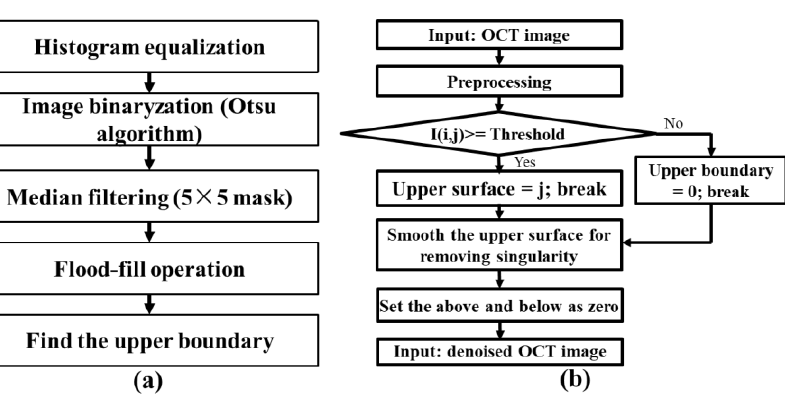
Figure 2. Background reduction using morphological analysis. ( a ) The procedure of background reduction. ( b ) The procedure of finding the upper boundary during background reduction. Algorithm 1: Proposed algorithm for denoising of OCT images.